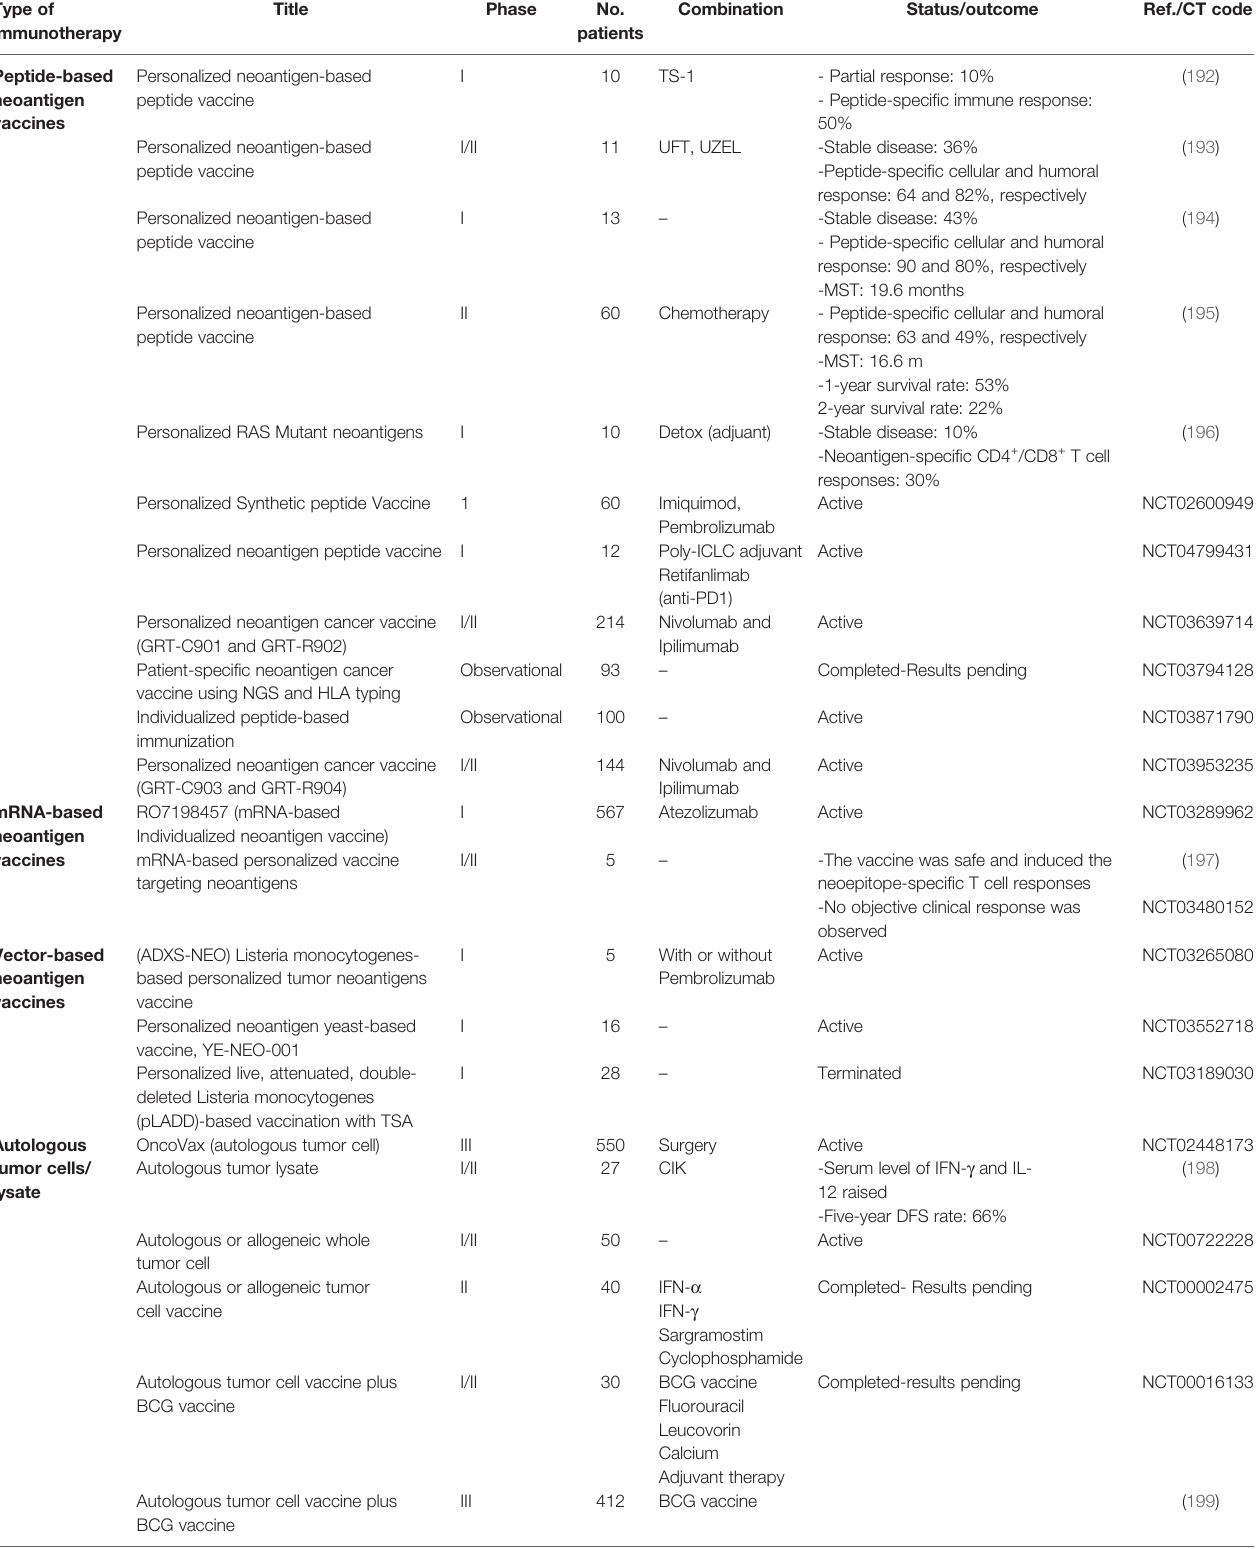
TABLE 2 | Clinical trials on personalized immunotherapy of